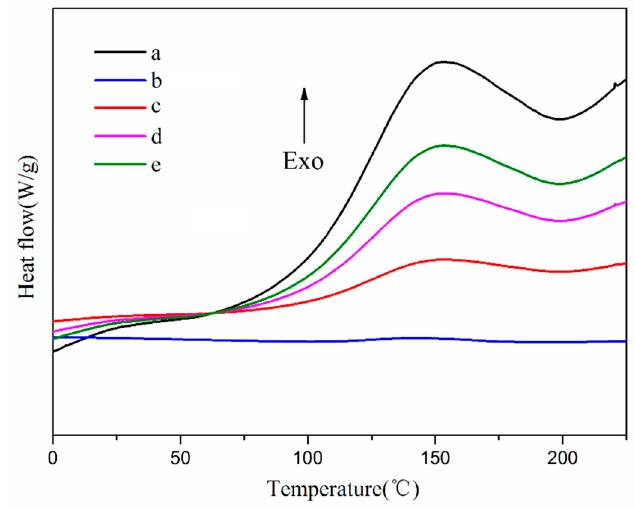
Figure 6. DSC heat traces of ( a ) TO, ( b ) shell, and TO-loaded microcapsules with core / shell ratios of ( c ) 2:1, ( d ) 3:1, and ( e ) 4:1.